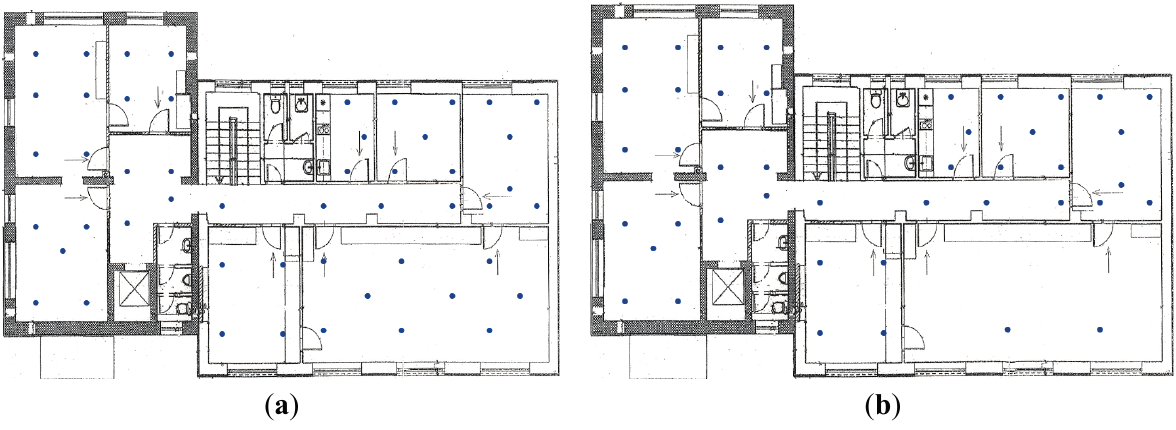
Figure 9. Indoor radio maps for ( a ) GSM and ( b ) Wi-Fi displayed on a plan of the